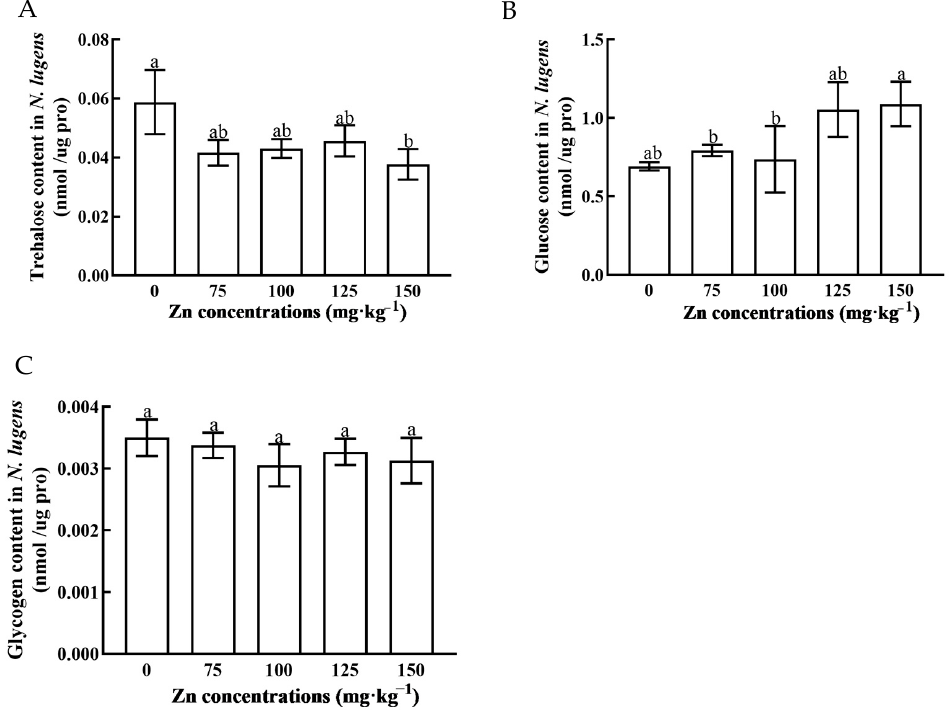
Figure 5. Effects of Zn accumulation in rice plants on trehalose ( A ), glucose ( B ), and starch ( C ) contents of N. lugens . The data are represented as mean ± SE ( n = 3). Tukey’s test was used to detect the significant differences among different groups, and different letters indicate significant differences.